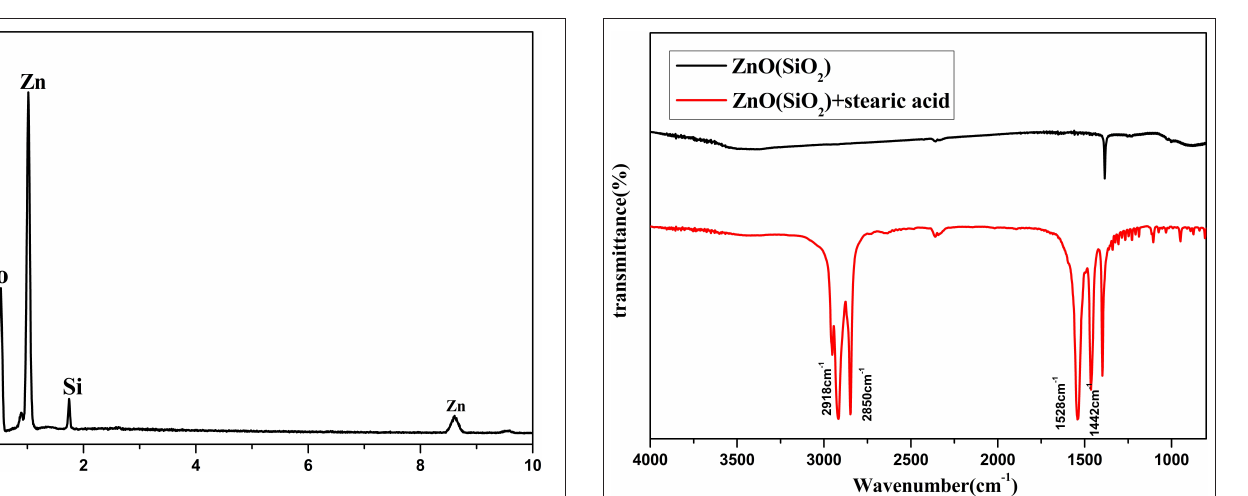
FIGURE 4 | EDS of SiO 2 shell on ZnO nanorod arrays.